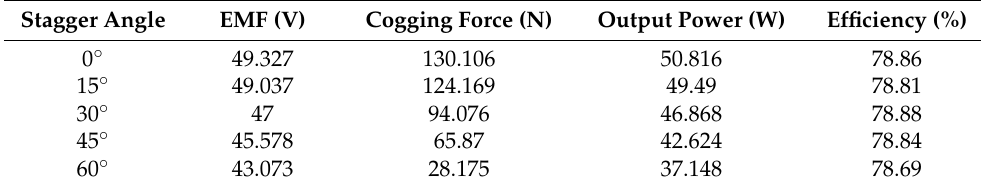
Table 1. Generator performance at different stagger angles.